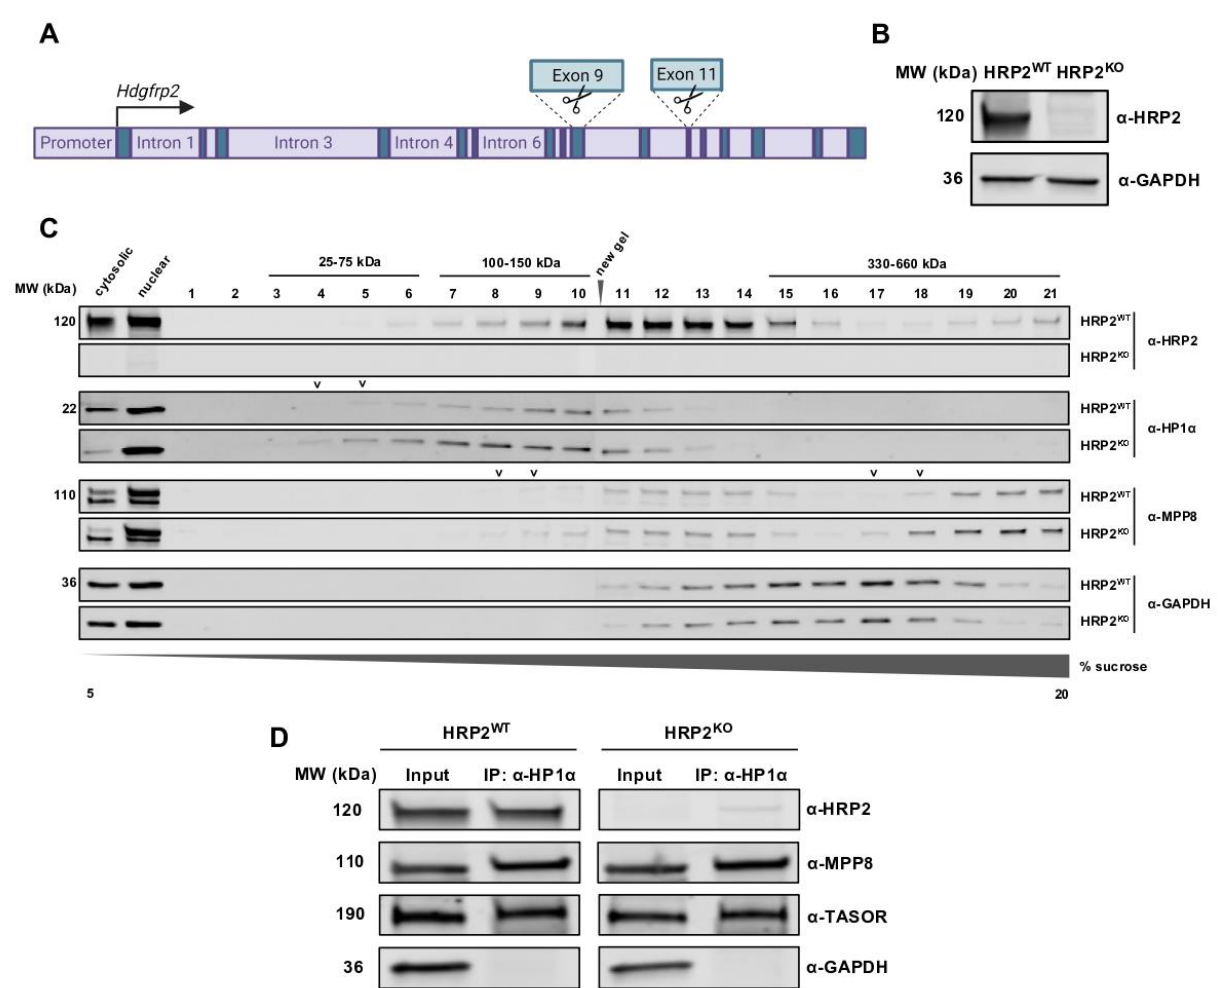
Figure 3. HRP2 co-sediments with H3K9me3-depositing complexes, and loss of HRP2 do not weaken HP1 α -HUSH interactions. ( A ) Map of CRISPR/Cas9 dual cutter gRNA target sites along the Hdgfrp2 gene. ( B ) Immunoblot of HRP2 WT and HRP2 KO 293T whole-cell lysates comparing levels of HRP2 and GAPDH. ( C ) Immunoblot detecting putative molecular complexes associated with HRP2, resulting from density gradient ultracentrifugation and fractionation. A total of 1.3 mg of HRP2 WT or HRP2 KO 293T nuclear lysate was run on a 5–20% sucrose gradient. The resulting gradient was fractionated in 500 µ L aliquots from lowest density (1) to highest density (21). Fractions distinguished with “ ∨ ” indicate leftward shifts of proteins to lower density fractions in the absence of HRP2 expression compared to wild-type conditions. ( D ) HP1 α co-immunoprecipitates with HUSH components in HRP2 WT and HRP2 KO 293T whole-cell lysates.